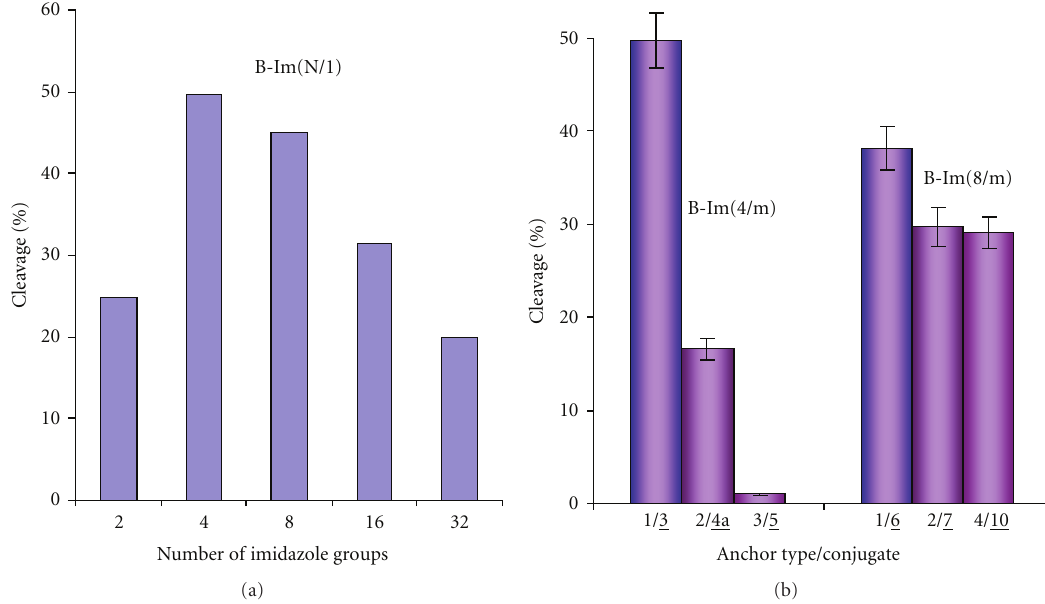
Figure 4: Structure-activity correlations found for the conjugates B-Im(N/m) . (a) Correlations between the number of imidazole groups in catalytic parts of conjugates and their catalytic activities. Cleaving data corresponds to incubation of the RNA with conjugates 1 , 3 , 6 , 9 , and 13 under standard conditions for 1h. (b) Correlation between the type of anchor groups and catalytic activity of conjugates. Diagram presents data for tetraimidazole-containing conjugates 3 , 4a , 5 ( B-Im(4/m) ) and octaimidazoles-containing conjugates 6 , 7 , 10 ( B-Im(8/m) ).